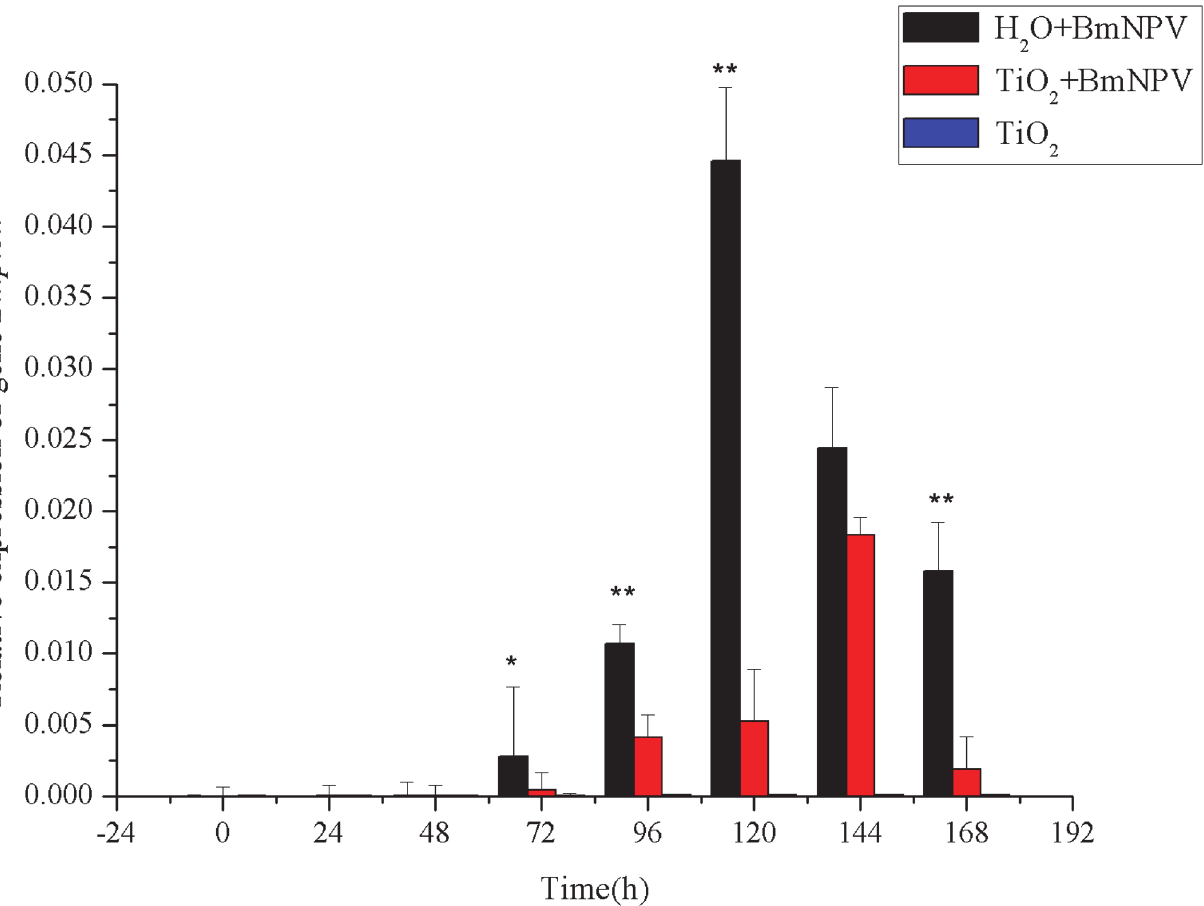
Fig 8. Relative expression of Bmpi3k . Black and red histograms represent the control group and the experimental group, respectively, and blue histograms represent the TiO 2 NPs-treated group. X and Y axes represent the time after infection and the relative expression of Bmpi3k , respectively. The bars in the figure with different letters indicate statistically significant differences ( p <